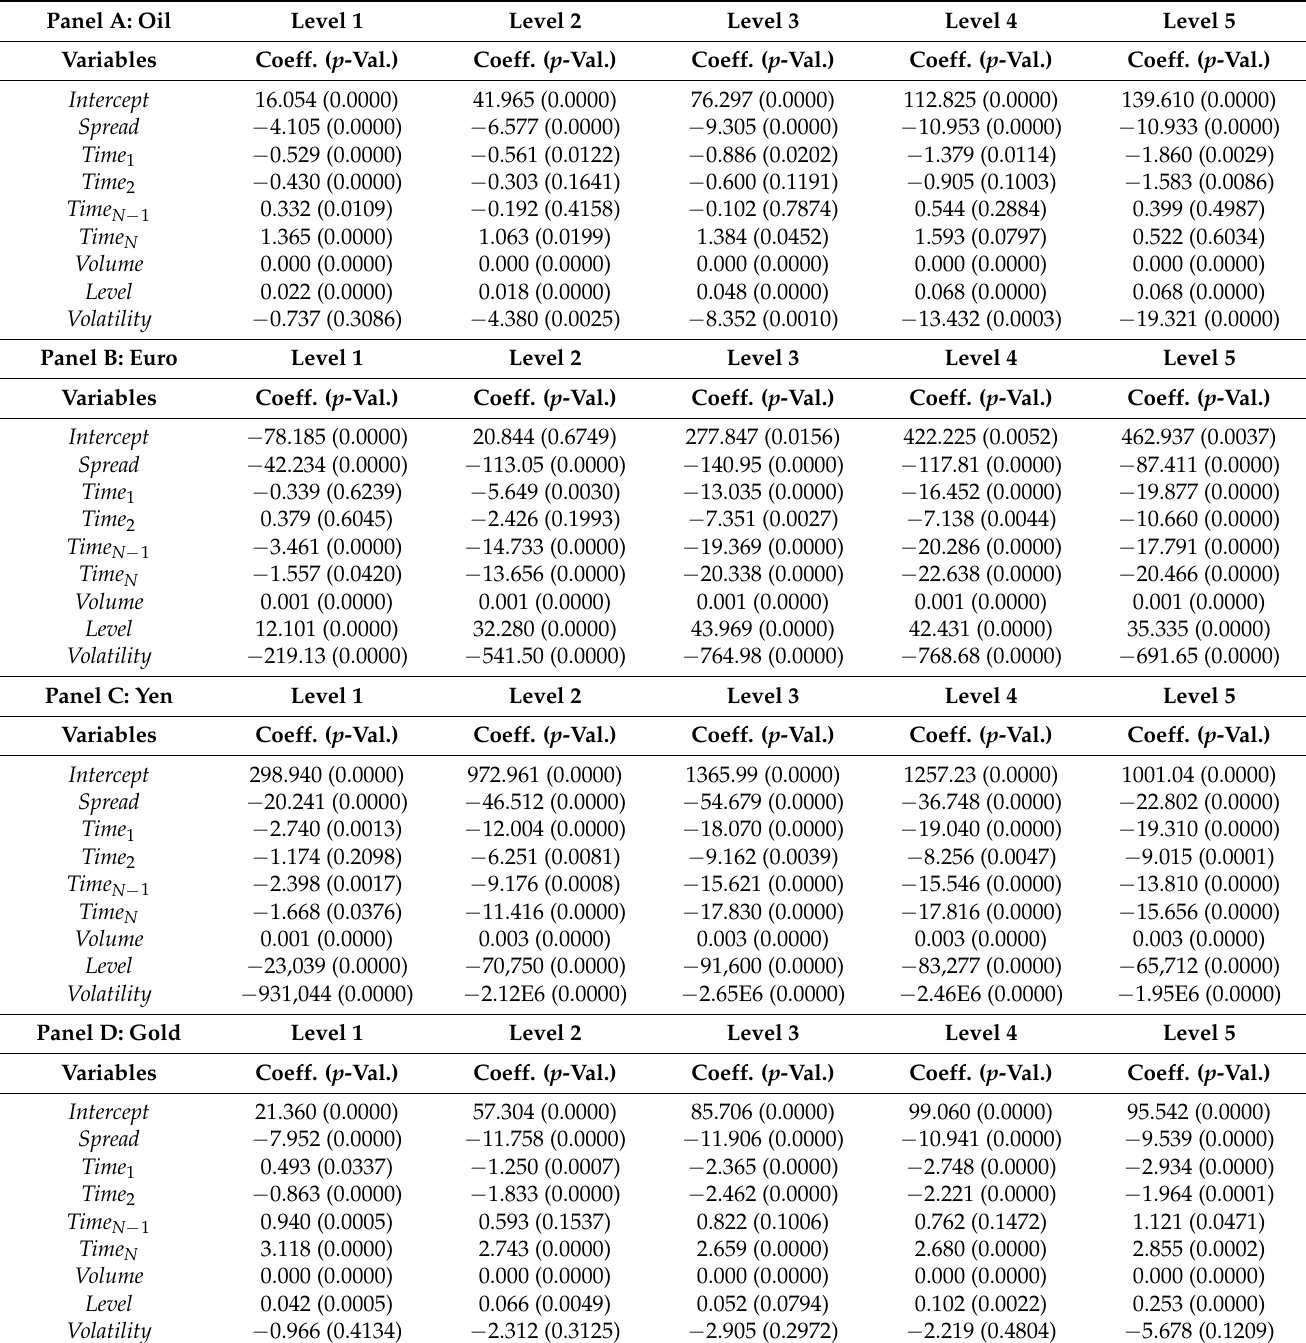
Table 7. Depth–spread relation at each